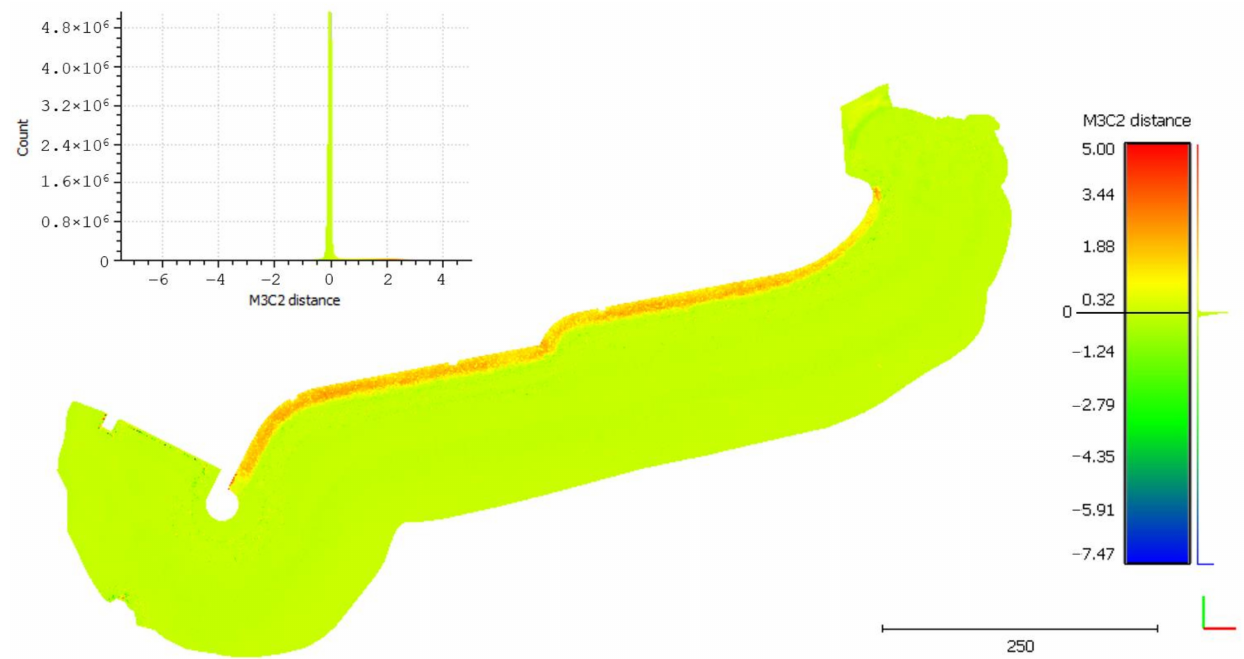
Figure 6. Comparison between digital surface model (DSM) 1 (reference surface) and DSM 2 (compared surface). The histogram shows the distribution of distance values.